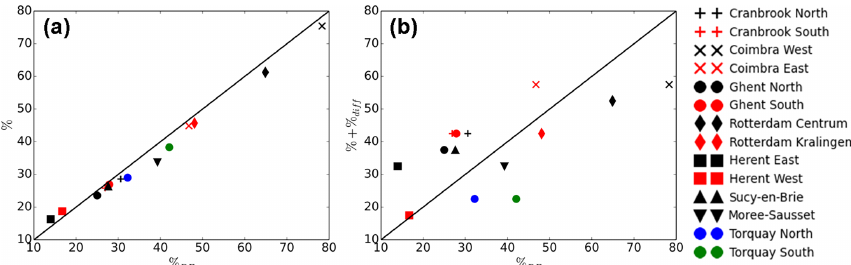
Figure 10. The percentages of distributed imperviousness (%) at the highest data resolution (a) and of the imperviousness of semi-distributed models (% + % diff ) (b) as a function of the percentages of imperviousness resulting from the fractal dimension estimates (% D line indicates the first bisector.